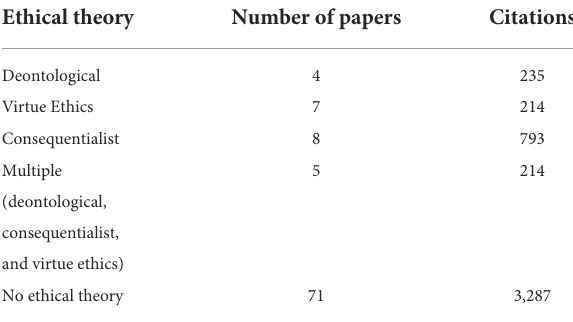
TABLE 7 Number of papers and citations according to their ethical